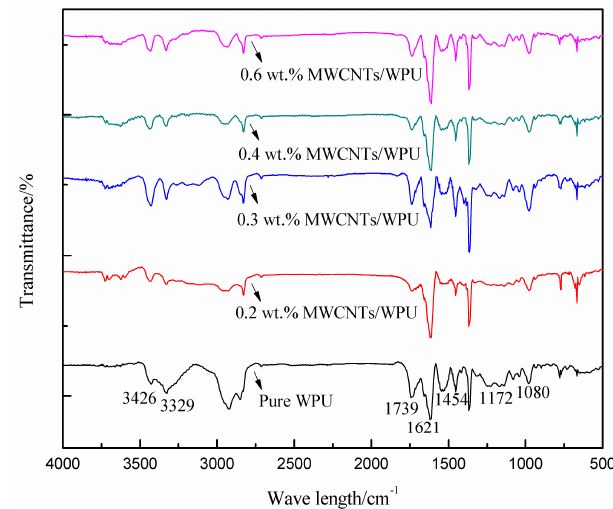
Figure 1. FTIR spectra of MWCNTs/WPU coatings with different MWCNTs contents.